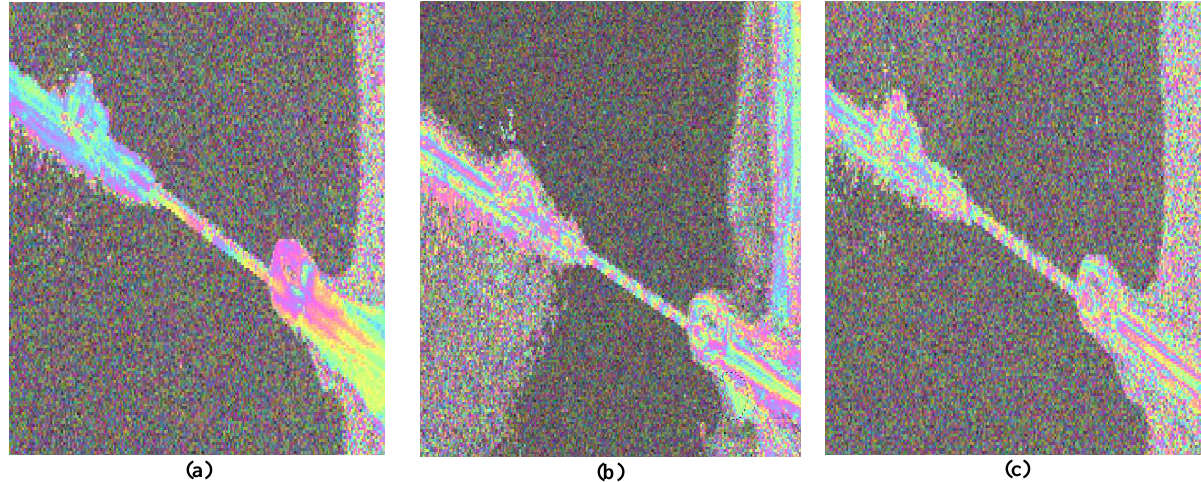
Figure 3. Examples of X-band interferograms over LU bridge (a) The 20140609-20140712 interferograms with temperature difference of 4.68°C (b) The 20140209- 20140712 interferograms with temperature difference of 24.08°C (c) The 20150206- 20140712 interferogram with temperature difference of 28.28°C